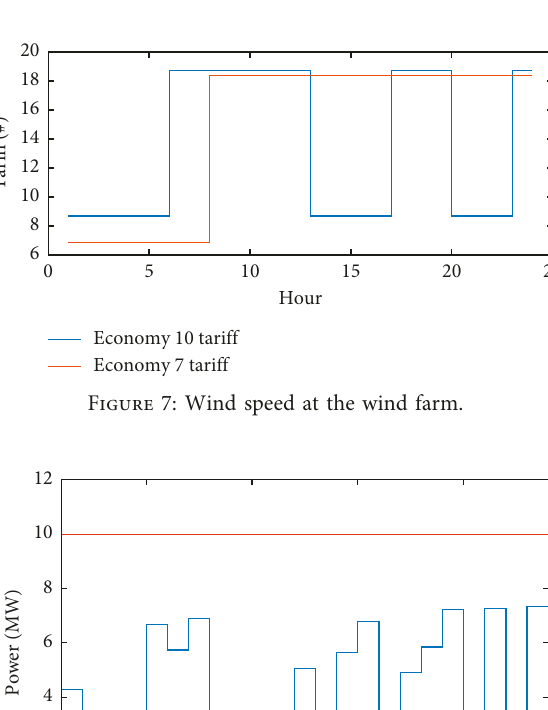
Figure 9: Demand of the community.